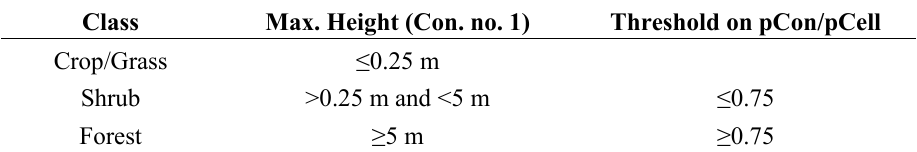
Table 2. Definition of vegetation classes in the voxel